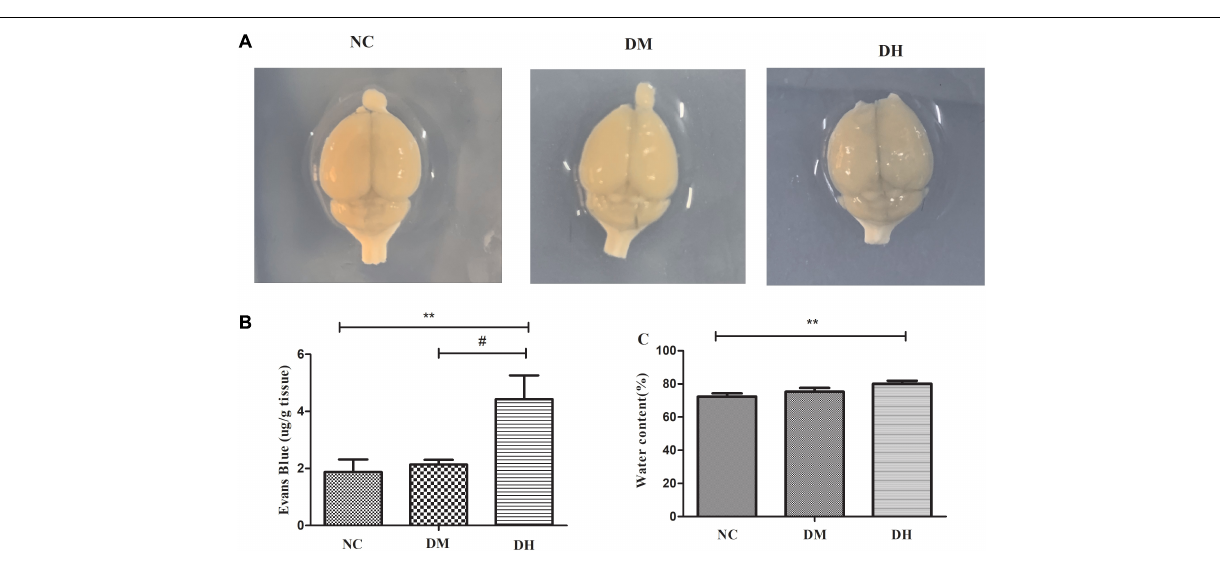
supply to the brain is essential for maintaining cognitive